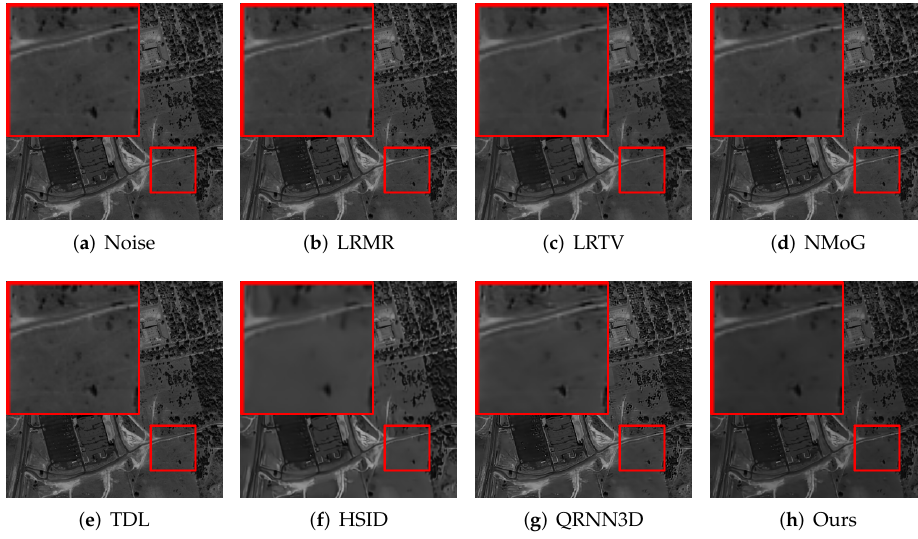
Figure 13. A comparison of our method using the Urban real dataset.